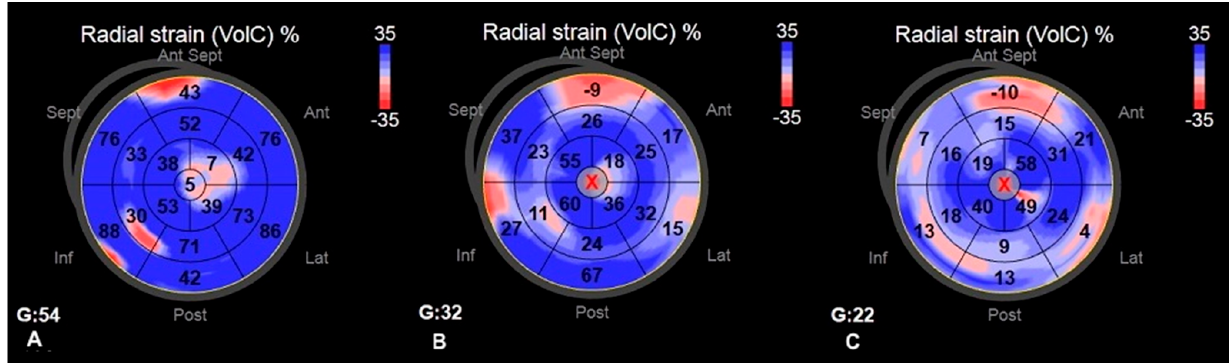
Table 3. Cut-off values and prognostic accuracy of the analyzed 2D and 3D STE parameters (calculated in the ROC analysis) as predictors of AF presence.